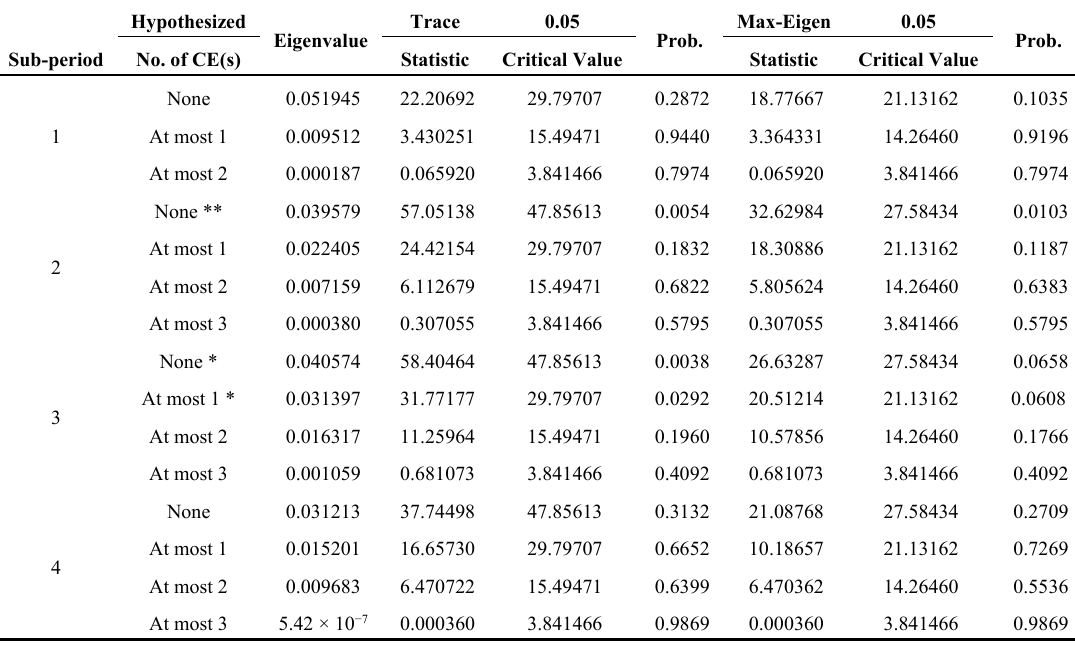
Table A14. Test for Possible Regional Cointegration in Europe.